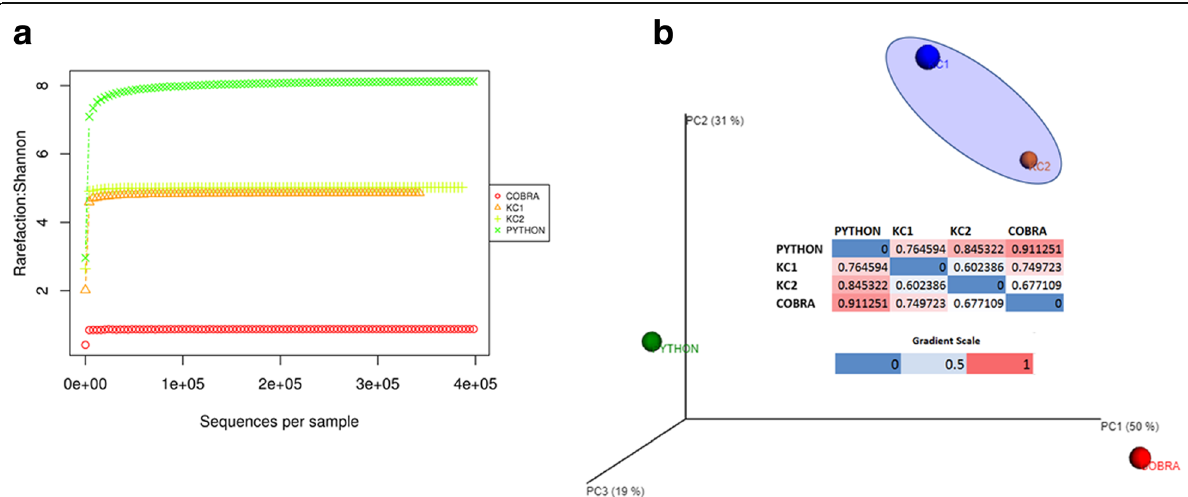
Fig. 4 Alpha and beta diversity analysis of snake oral samples. a The rarefaction curve plotted using Shannon metrics to observe the species richness and evenness within the samples. The Shannon diversity index, estimated as 8.12 based on observed OTU abundances, indicates that the Python oral cavity (green asterisk) contains a higher number of species than the other samples; b Principal Coordinate Analysis of bacterial communities among the samples. The plot indicates that the King Cobra 1 and King Cobra 2 samples share a common taxon. Python and Cobra were uniquely distributed. All metrics were calculated using the software QIIME